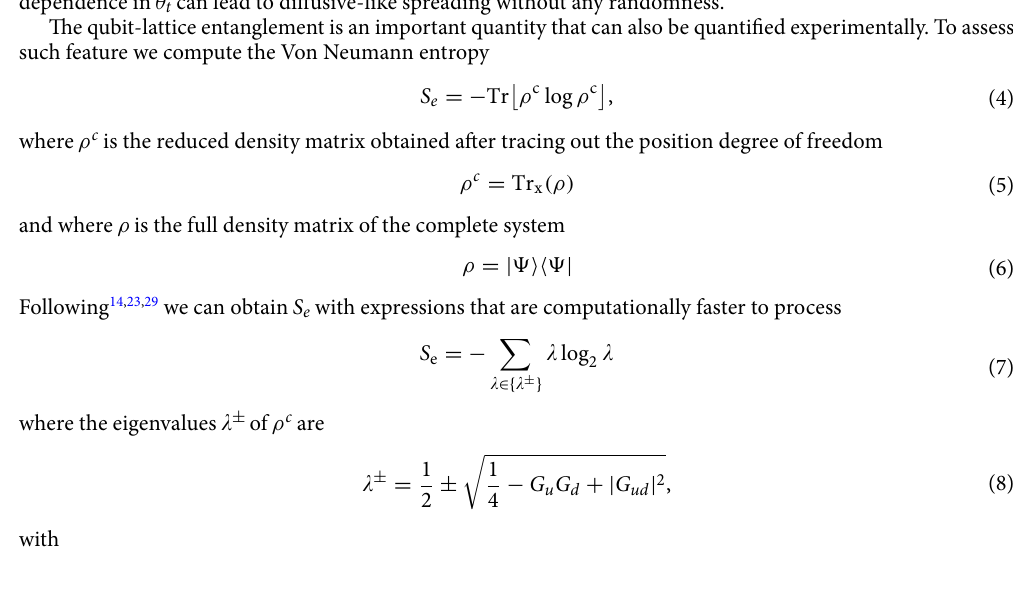
5 10 5 after discarding the transient = ×